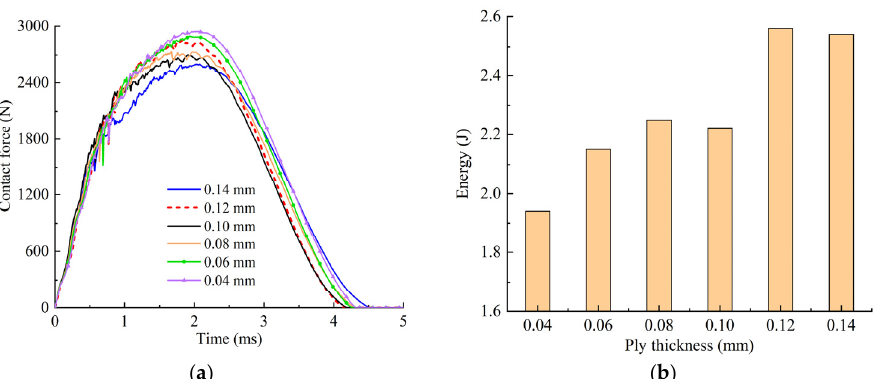
Figure 20. Comparison of contact forces and energy absorption with different single ply thicknesses. ( a ) Contact force curves. ( b ) Energy absorption.